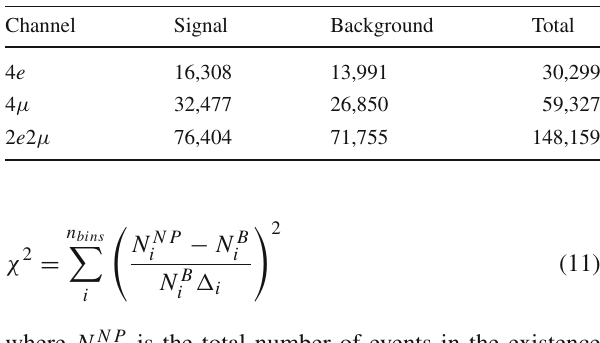
Fig. 8 Distributions of the reconstructed dilepton candidate mass for four-lepton events selected with both a leading and b sub-leading on- shell Z bosons Table 3 The number of events yielded for main background and signal (where all couplings are equal to zero, except C (cid:3) BW /(cid:3) 4 = 5 . 0 TeV − 4 ) offour-leptoneventsafterCut-5shownforeachfinalstateandcombined at FCC-hh with L int = 10 ab −